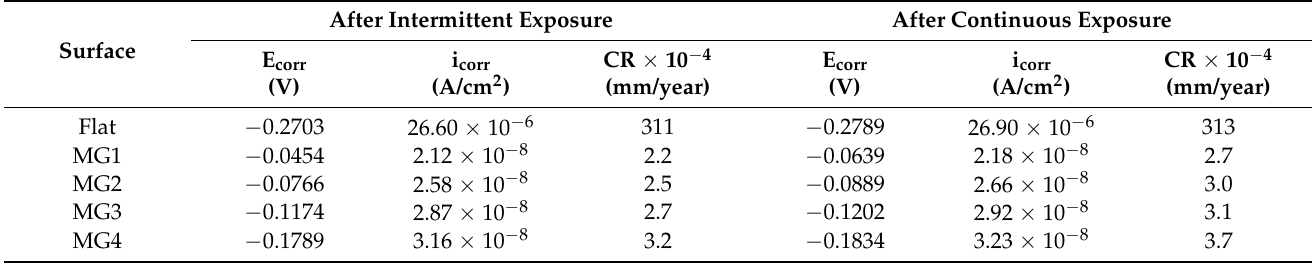
Table 4. Corrosion potential (E corr ), corrosion current density (i corr ) and corrosion rate of surfaces, after long-term exposures to 3.5 wt. % NaCl solution.